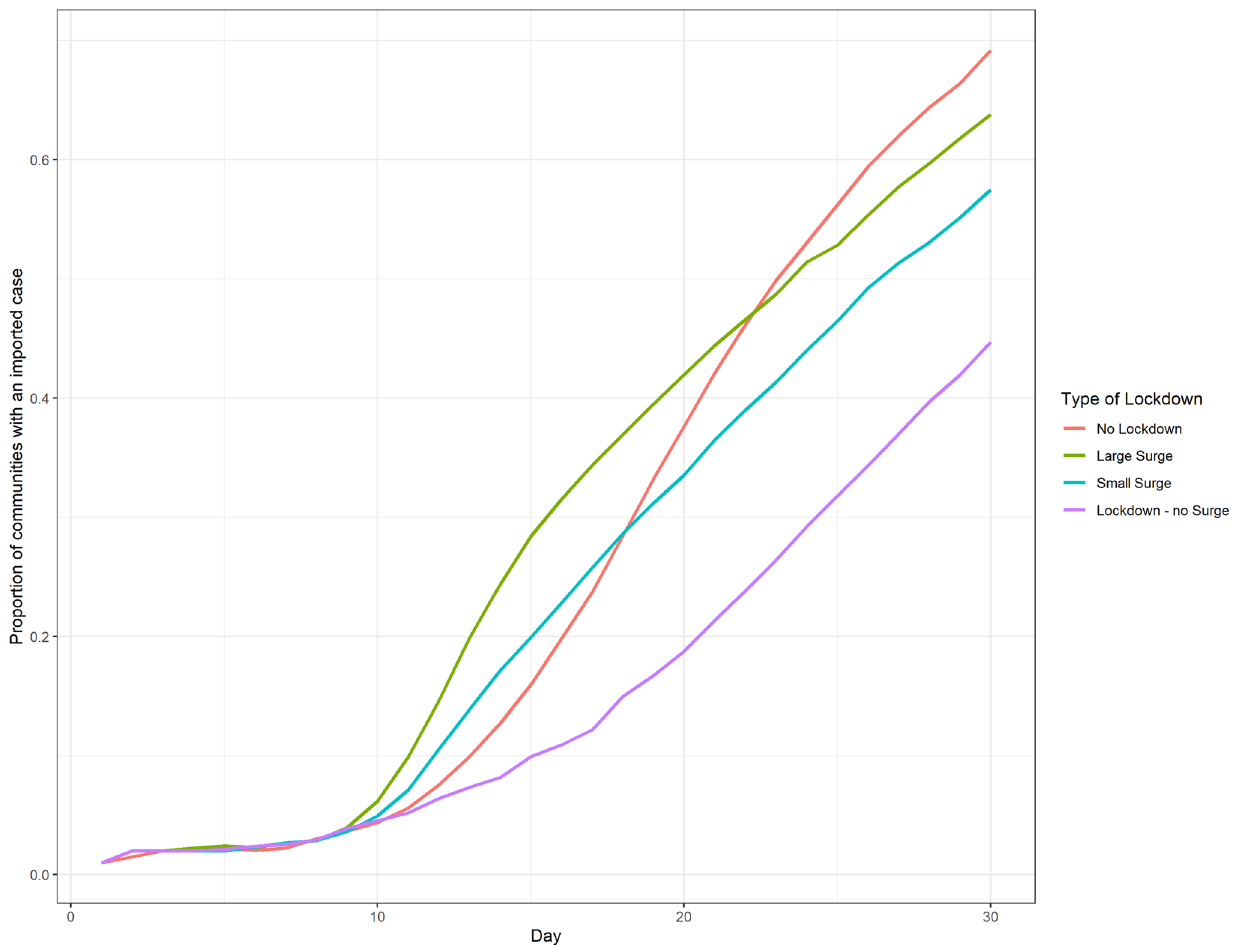
Figure 5. Average proportion of simulated communities with an imported case. Initially the epidemic spread quicker in simulations with a large or small surge, however, simulations with no lockdown result in a larger overall epidemic size and eventually spread more